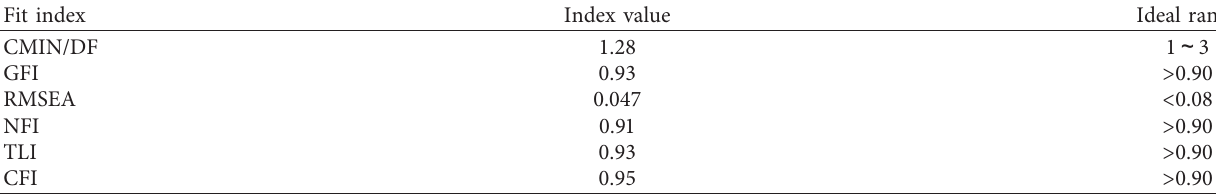
Table 5: Fit statistics of second-order confirmatory factor analysis model.